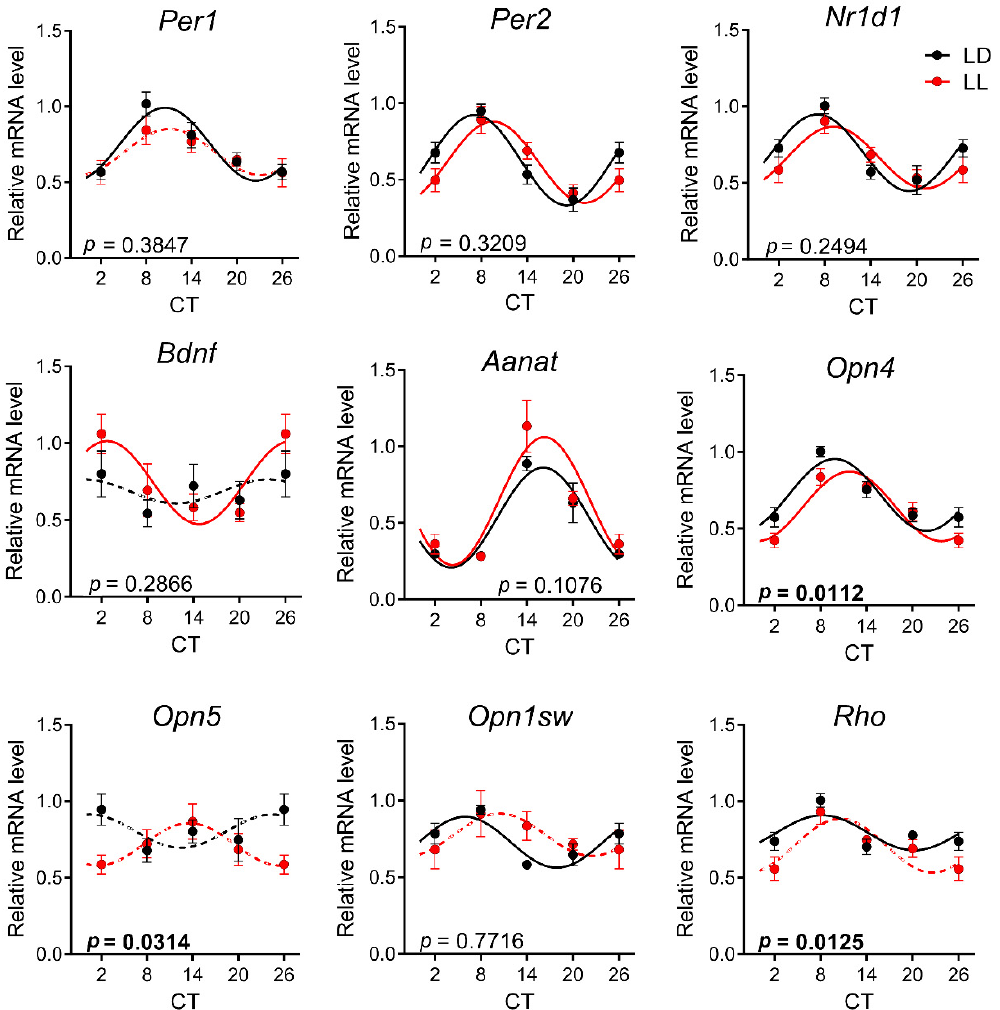
Figure 5. Effect of development under constant light (LL, in red; controls in LD in black) on rhythmic gene expression in the retina at P90. Animals were housed under LL (16 lux) from P0 until P20 and then released into LD conditions. At P90, the animals were sacrificed in 6 h intervals in DD and retinas were processed by qPCR with specific TaqMan probes. Rhythmicity was proved by cosinor analysis with a horizontal line as zero hypothesis and one-way ANOVA for differences between the time groups. Full lines indicate rhythms confirmed by cosinor analysis and one-way ANOVA. Dashed lines indicate profiles not confirmed for rhythmicity by one or both methods. Each point represents the mean ± SEM from five to seven animals. p -values indicate group differences by two-way ANOVA, and significant values are in bold.